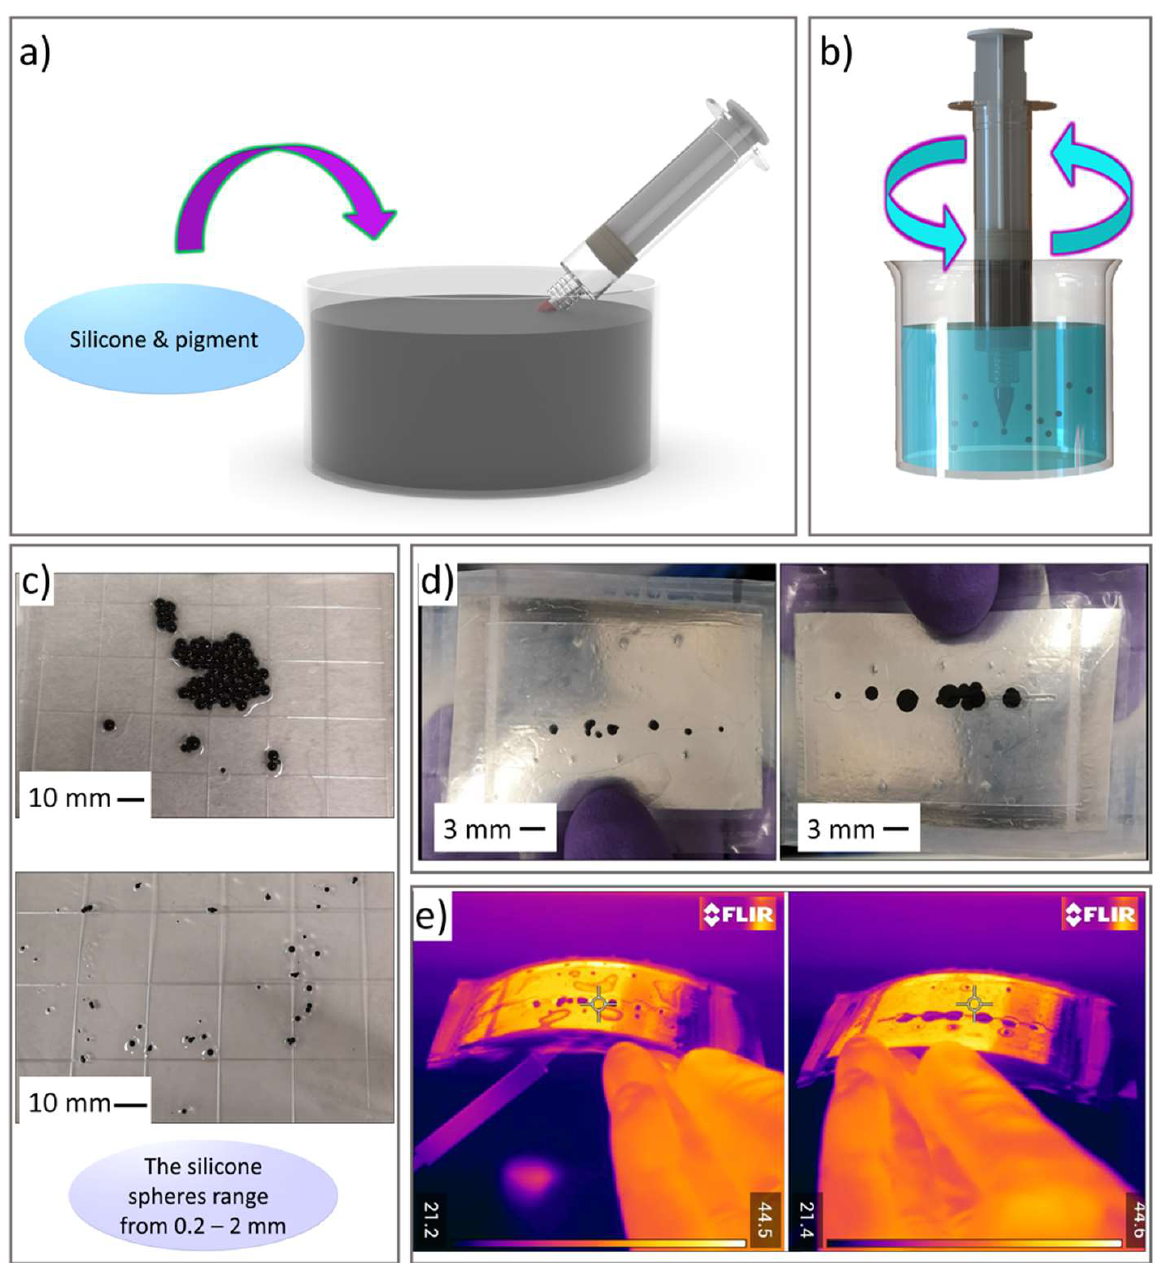
Figure 11. ( a , b ) Schematic illustration of the fabrication of silicone based chromatophores spheres. ( c ) Sizes of the silicone spheres that can be achieved depending on the speed of stirring and the gauge of the dispensing needle tip. ( d ) The silicone spheres after placement in an IR transparent polyethylene pouch with a metalized background. ( e ) Images of deformed and undeformed spheres using a FLIR IR camera while reflecting a warm object to demonstrate an apparent local change in temperature.